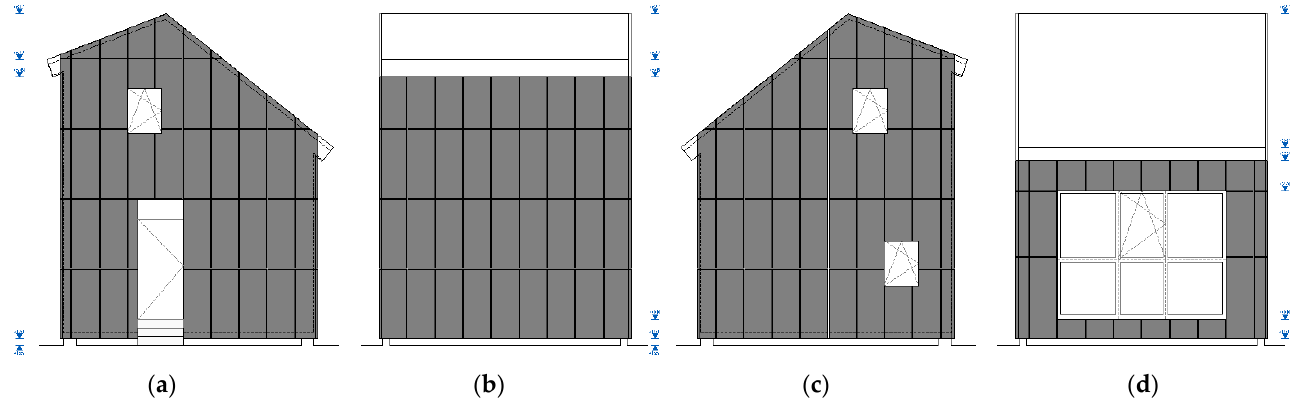
Figure 4. Exterior views of the designed experimental module: ( a ) E orientation; ( b ) N orientation; ( c ) W orientation; ( d ) S orientation.